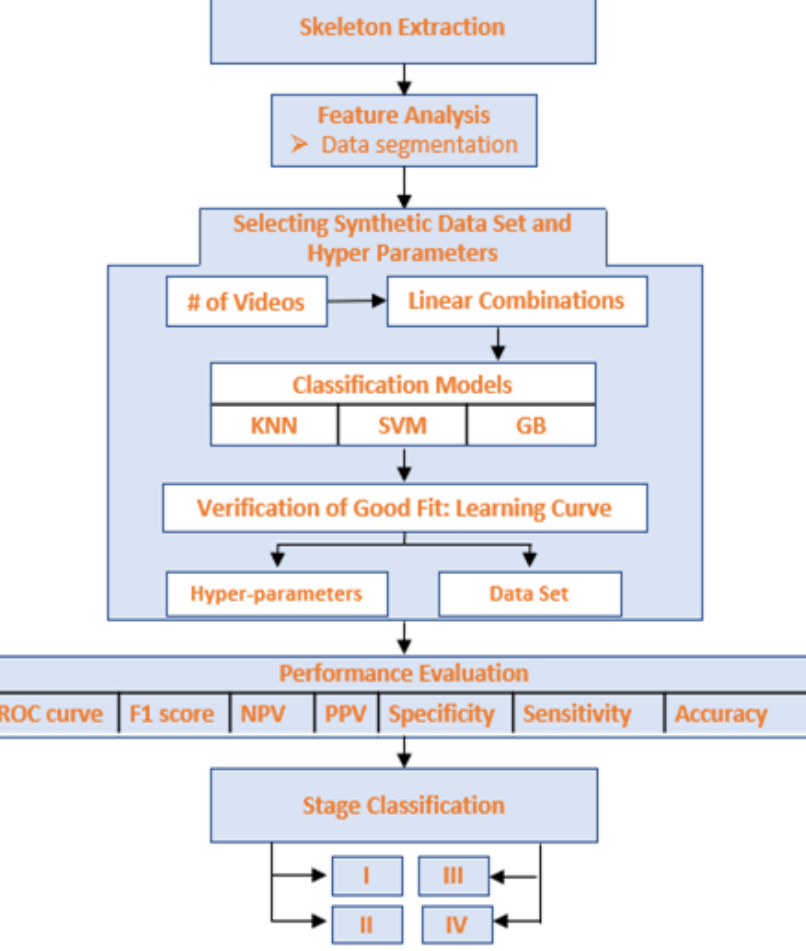
Figure 2. Proposed method for Parkinsonian gait analysis using pose estimation and synthetic